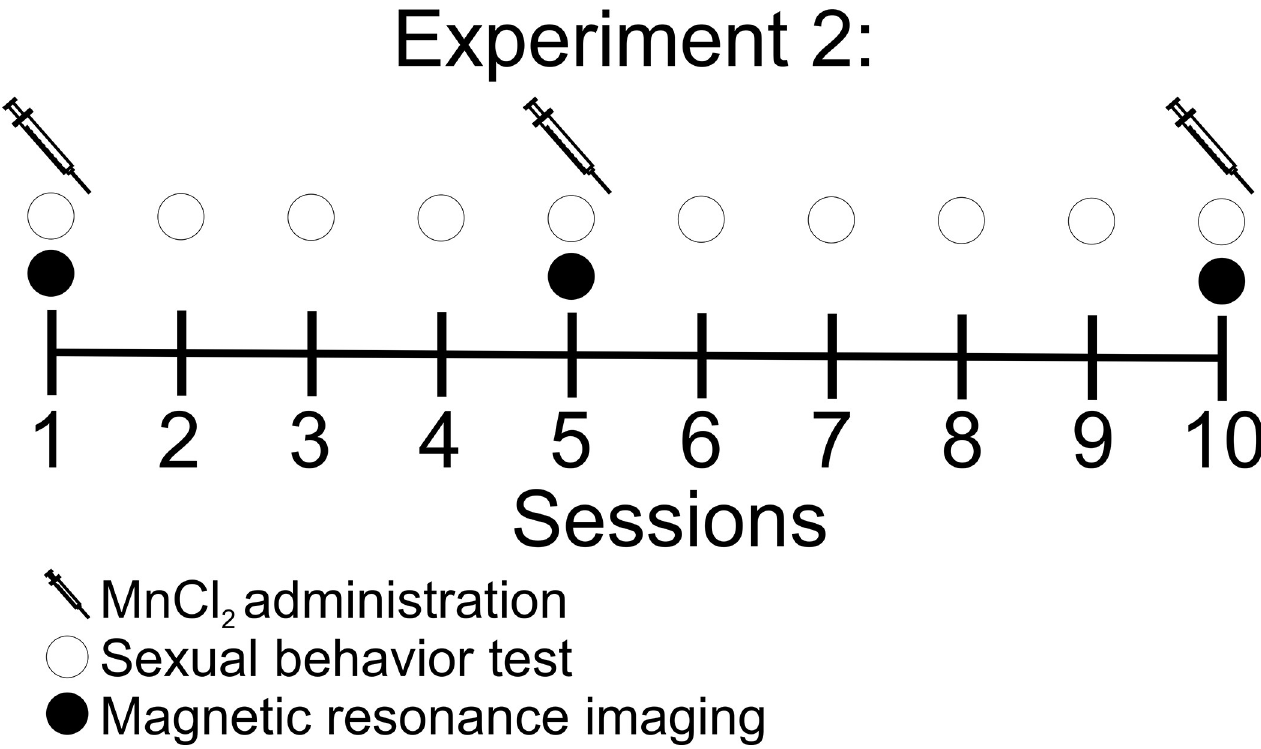
Fig 2. The timeline of experiment 2 was similar to that of experiment 1. Subjects were tested once a week for 10 consecutive weeks for sexual behavior. The control groups were left alone in the mating cage for 30 minutes. Twenty-four hours before sessions 1, 5 and 10 subjects were injected with 8 or 16 mg/kg of MnCl 2 depending on the group. They mated pacing the sexual interaction. The control females did not mate. Immediately after the test, MR images were